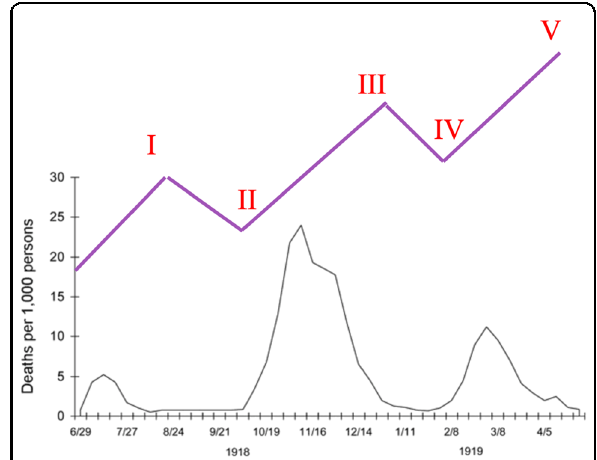
Fig. 4 Three cycles of illness during pandemic in fl uenza (Spanish fl u) of 1918 – 1920 (black). Hypothetical Elliott wave (purple) is overlaid on the plot to demonstrate correspondence of deaths with different waves of the pandemic. Adapted from: https://www.cdc.gov/ fl